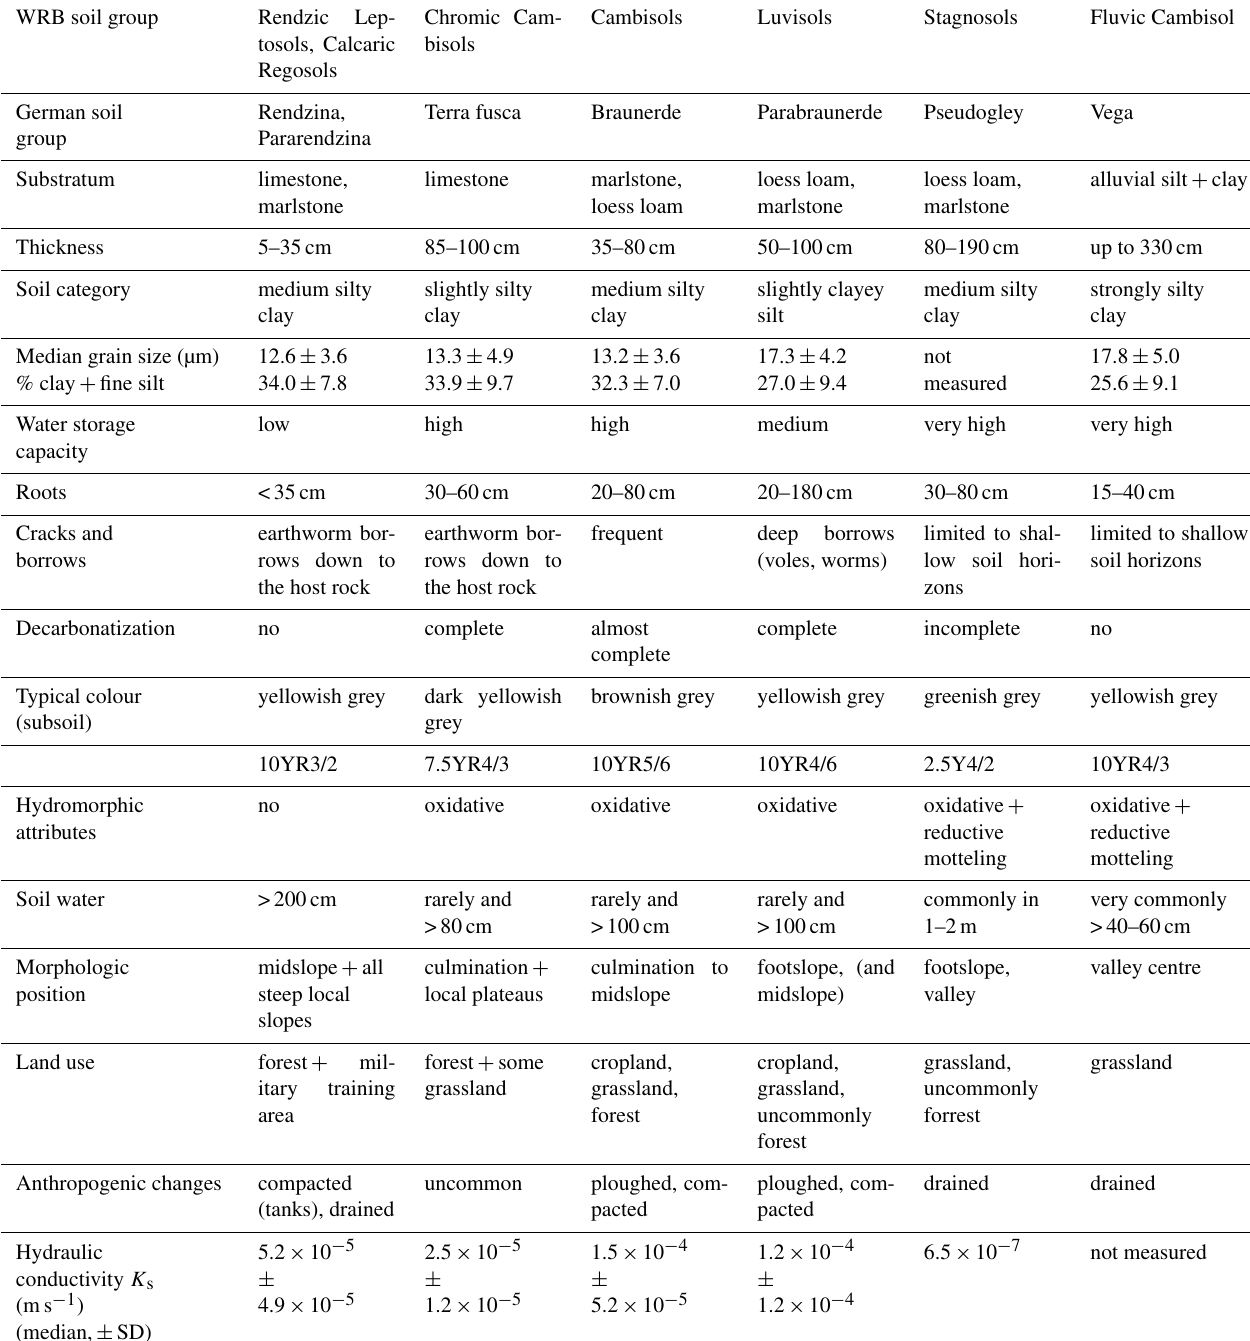
Table 1. Soil groups (WRB, 2003, and AG Boden, 2005), soil texture and soil hydraulic properties. WRB soil